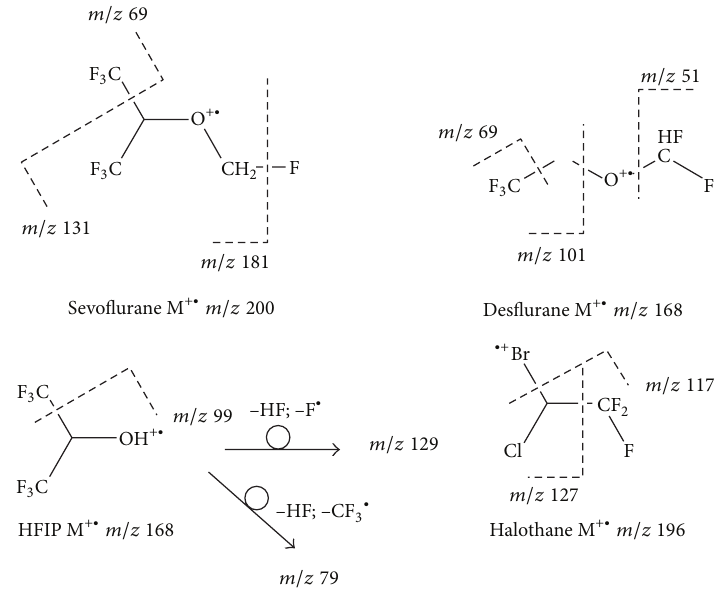
Figure 2: Rationale of the fragmentation processes explaining the selected peaks for the SIM analysis.